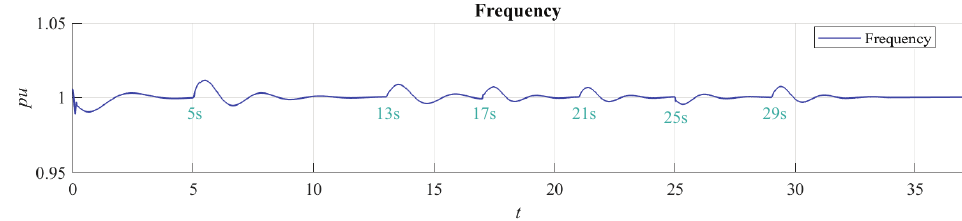
Figure 26. System frequency in per unit for case study